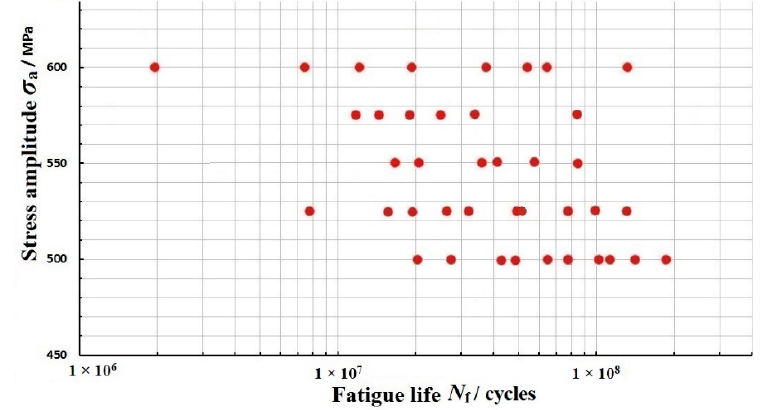
Figure 3. The test results for fatigue.